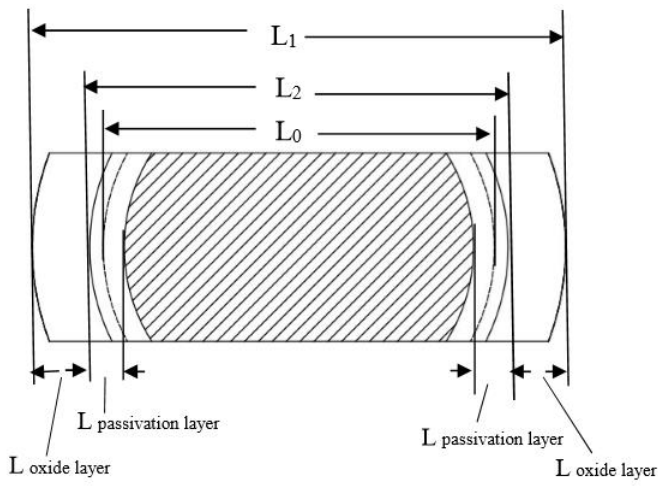
Figure 4. Parameters of oxide film.